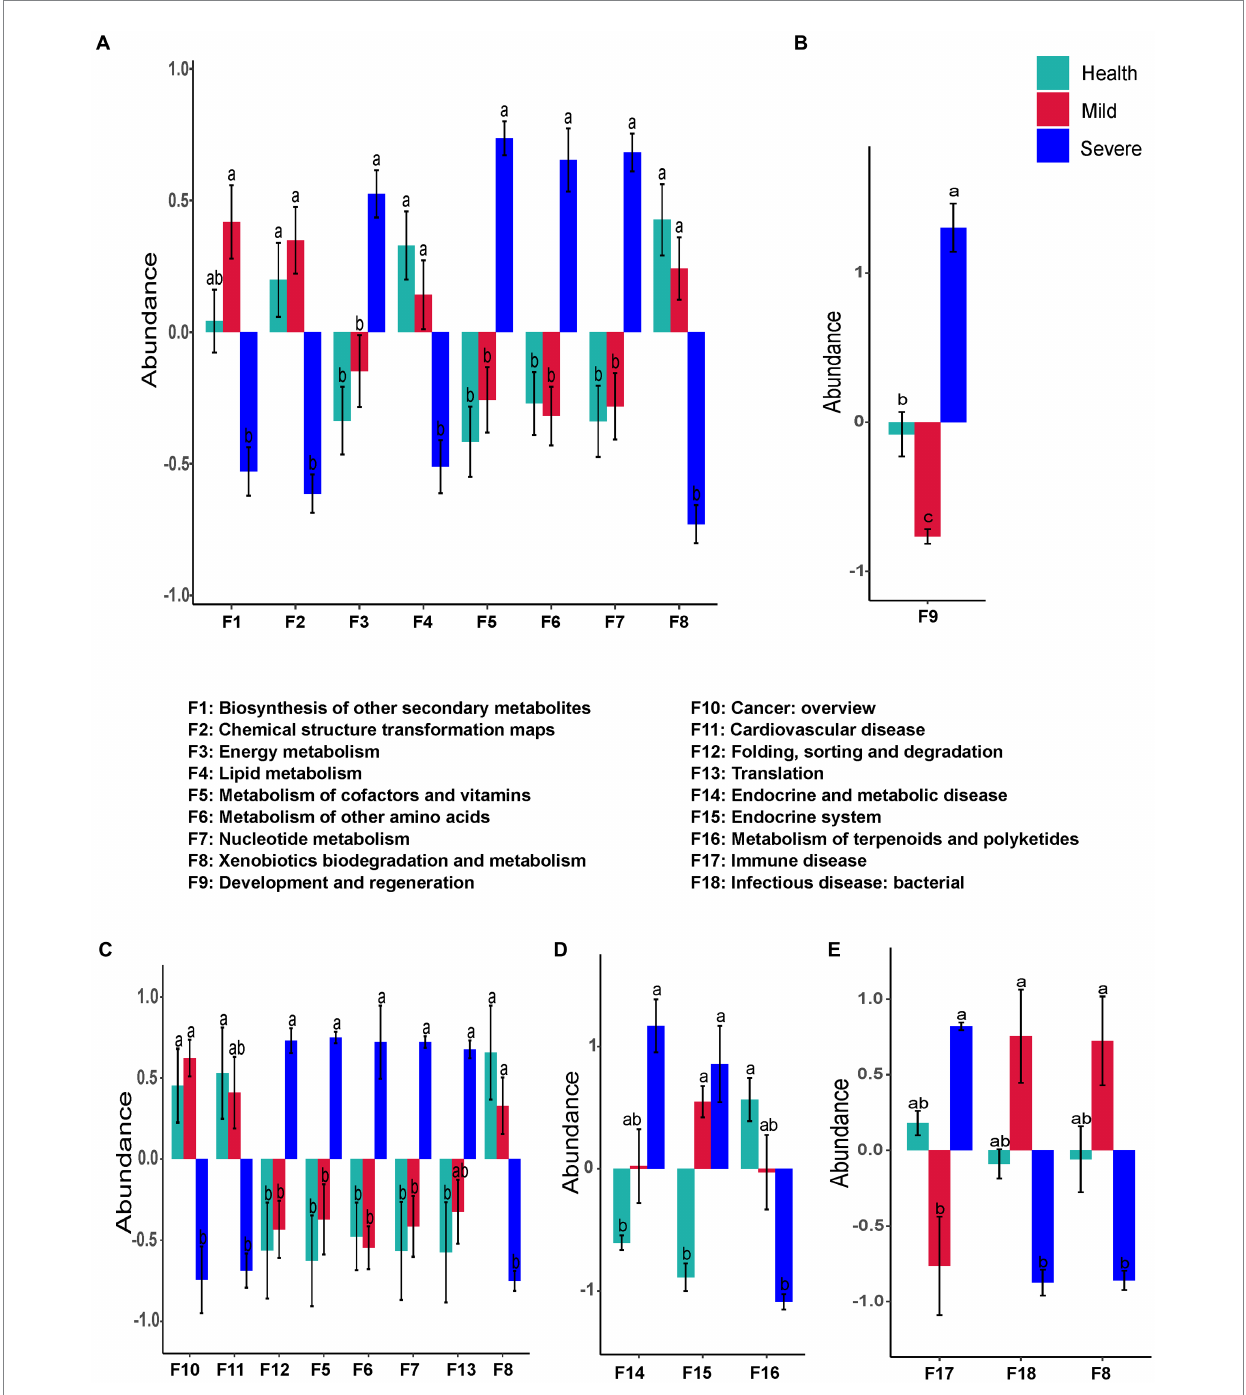
FIGURE 6 The bacteria flora predicted functions that had a significant difference between groups. (A) Total samples from all sampling sites; (B) samples from the forehead; (C) samples from the cheek; (D) samples from the chin; (E) samples from check and back. The different alphabet on the column represented there was a significant difference between